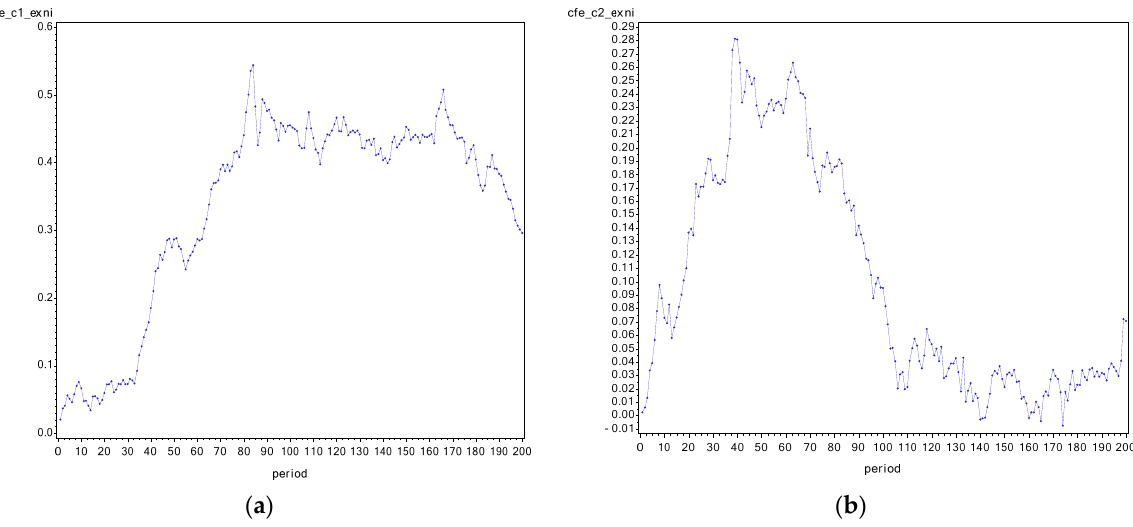
Figure 3. CFE graph for AR; cfe_c1_exni means CFE for AR in 2014 and cfe_c2_exni means CFE for AR in 2019. The actual figures after the focal episode are subtracted from the forecasts via the MLE procedure. ( a ) The first focal episode on 10 January 2014; ( b ) the second focal episode on 8 July 2019. Figures imply that the impact of the Indonesian export ban in terms of AR in 2014 is relatively larger than that of in 2019.